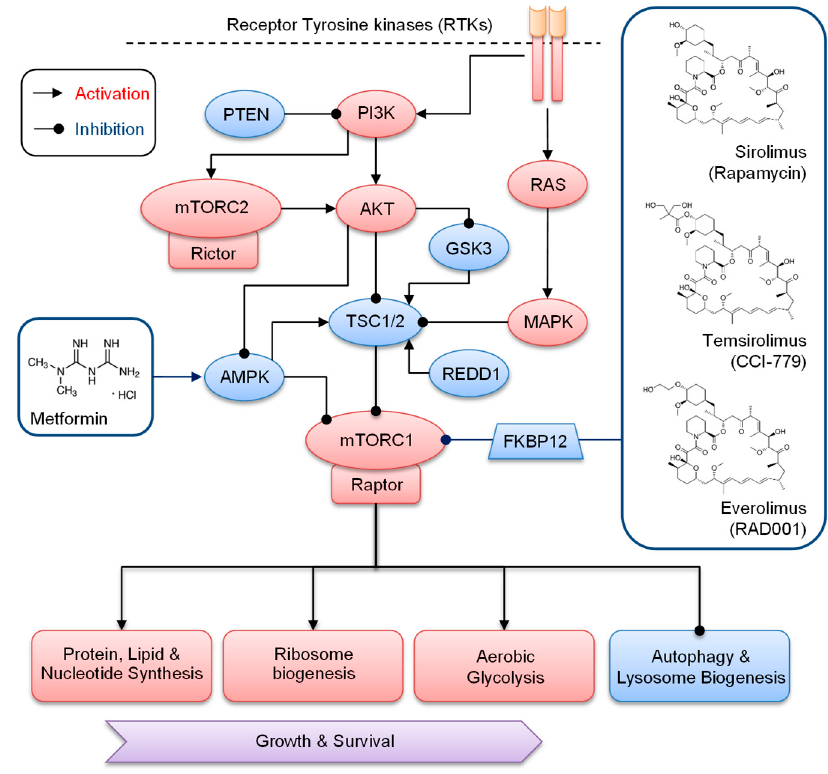
Figure 1. Regulation and targeting mTORC1 by rapalogs and metformin in cancer. Associated with raptor or rictor, mTOR kinase functions in two distinct complexes: mTORC1 and mTORC1, respectively. In cancers, hyperactivated RTKs together with downstream PI3K/AKT, RAS, and MAPK pathways activate mTORC1 via phosphorylation and inactivation of TSC1/2. In proliferating cells, PI3K-mediated phosphorylation of mTORC2 increases AKT activity, which in turn inhibits TSC1/2 regulators, AMPK, and GSK3. During energy stress, such as hypoxia, REDD1 inhibits mTORC1 activity via TSC1/2. Frequent mutations of PTEN, which antagonizes PI3K, keep AKT in the active state. Hyperactivated mTORC1 promotes cancer growth and survival by the stimulation of protein, lipid, nucleotide, and ribosome synthesis, aerobic glycolysis, and inhibition of autophagy and lyso- some biogenesis. Sirolimus (rapamycin), temsirolimus (CCI-779), and everolimus (RAD001) inhibit mTORC1 by binding to FKBP12, which in turn interacts with mTORC1 and deters its autophosphory- lation and activation. Metformin inhibits mTORC1 by activating AMPK, which activates TSC1/2 and inactivates